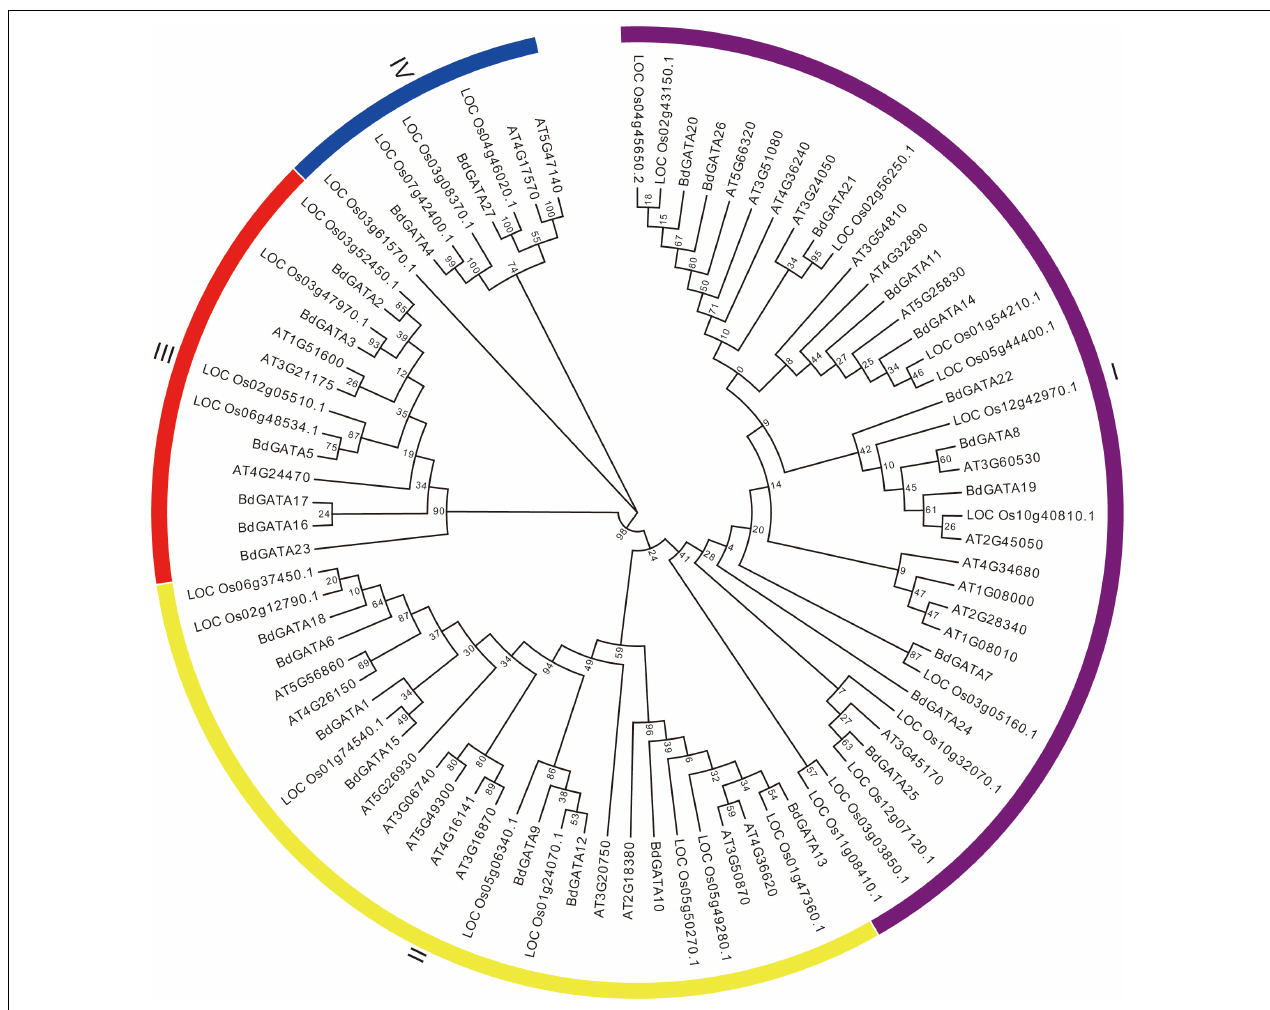
FIGURE 2 | NJ tree of GATAs in plants. The tree included 27 GATAs from Brachypodium , 29 from Arabidopsis and 28 from rice, and construction was based on the full-length protein sequences. Four subgroups of GATAs were classified as I, II, III, and